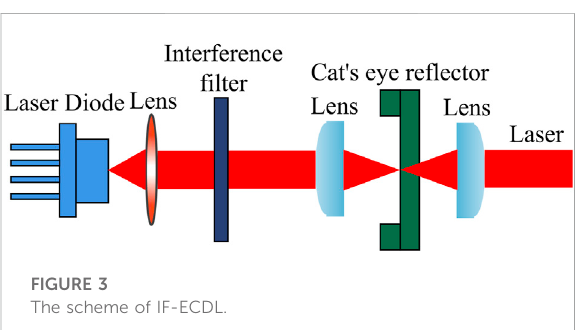
FIGURE 3 The scheme of IF-ECDL.